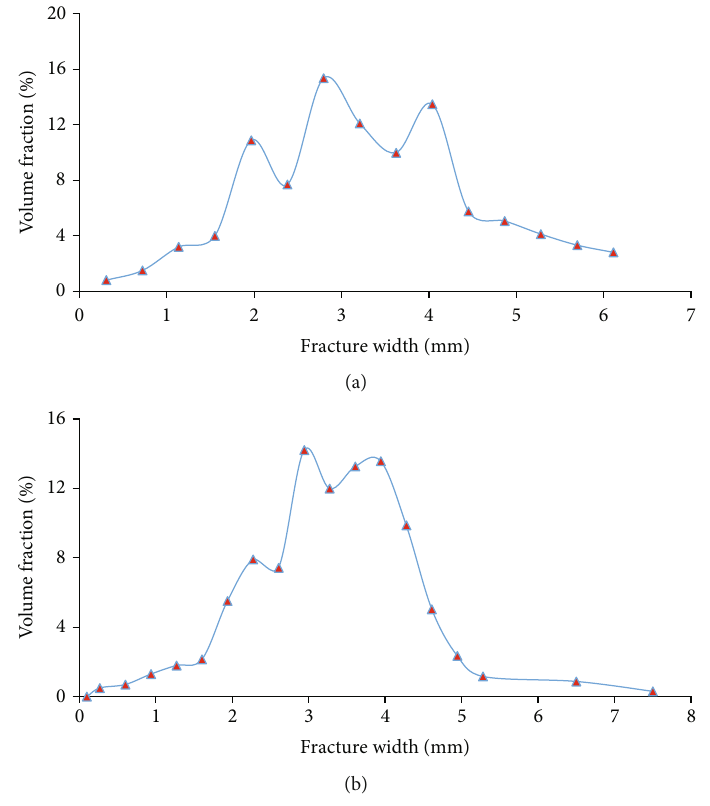
Figure 12: The fracture width of sample at the top (a) and bottom